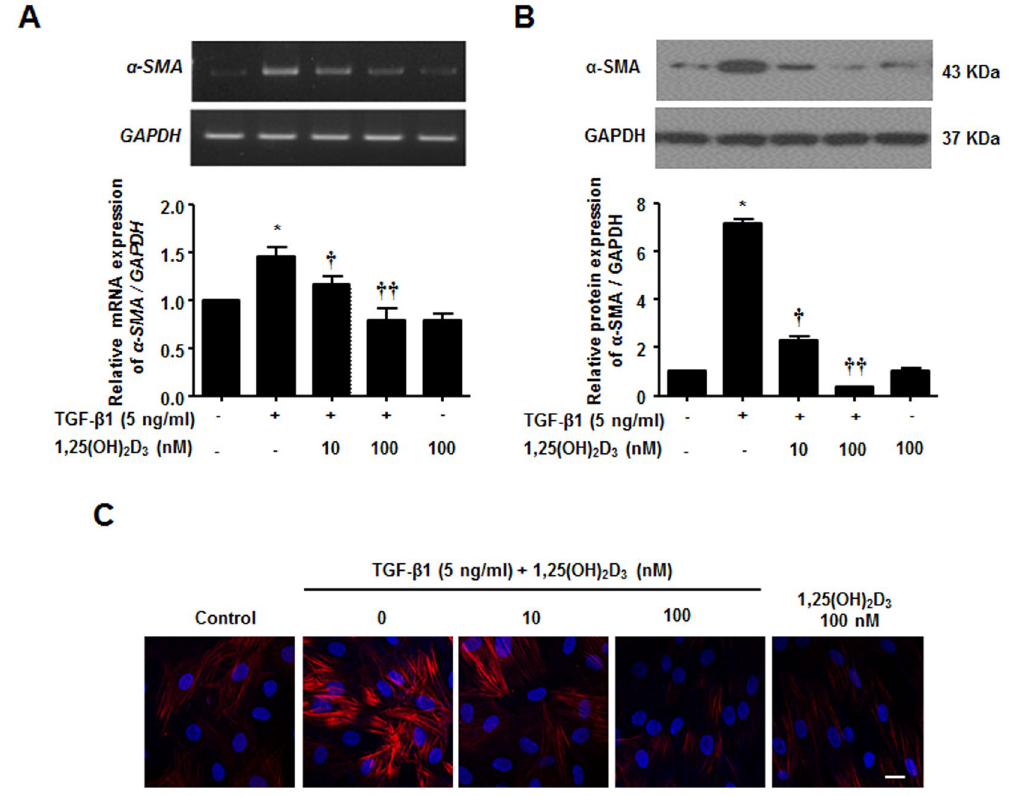
Figure 1. Inhibition of TGF- β 1-induced α -SMA mRNA and protein expression by 1,25(OH) 2 D 3 in nasal polyp-derived fibroblasts. Nasal polyp-derived fibroblasts were treated with TGF- β 1 and/or 1,25(OH) 2 D 3 or 1,25(OH) 2 D 3 alone for 72 hours. ( A , B ) Expression levels of α -SMA mRNA and protein were determined by semi-quantitative RT-PCR analysis and Western blotting analysis. Expression of housekeeping GAPDH was used as an internal control. A representative experiment and quantitative determination of α -SMA mRNA and protein levels are shown. ( C ) Representative fluorescein immunocytochemistry for α -SMA (red) with nuclear DAPI (blue). Scale bar = 50 μ m. All data are presented as mean ± SEM. Four primary cell lines from different donors were used. All experiments were performed in at least triplicate and repeated at least three times. * p < 0.05 vs. control, † p < 0.05, †† p < 0.01 vs. TGF- β